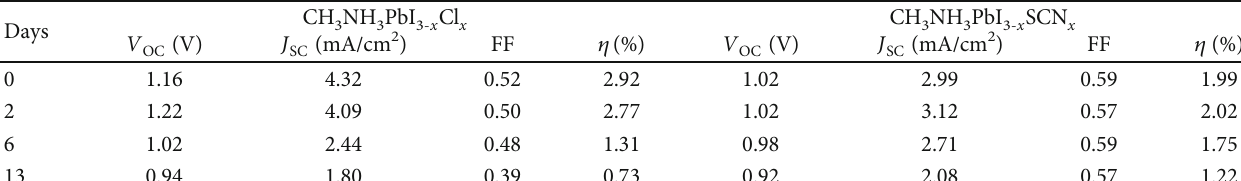
NH PbI Cl x and CH 3 3 3- x